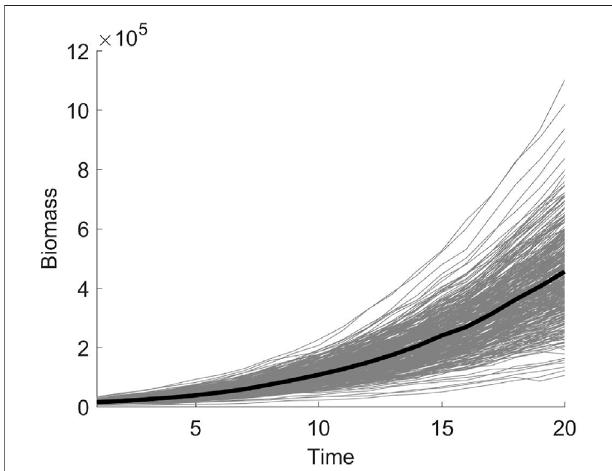
FIGURE 4 | The shoot biomass development trajectory of 350 samples. The solid gray line represents the trajectory curve of 350 samples, and the solid black line represents the average trajectory curve.